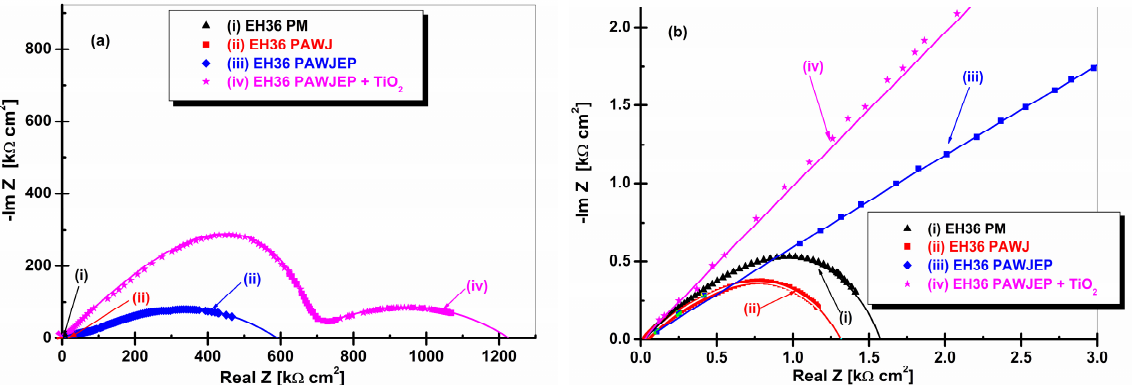
Figure 10. Electrochemical impedance spectroscopy diagrams in Nyquist representation for investigated samples in seawater on large frequency range ( a ) and zoom in low frequency range ( b ) for: (i) EH36PM without protective coating used like parent material, (ii) EH36PAWJ without protective coating, (iii) EH36PAWJEP coated with polymeric primer and (iv) EH36PAWJEP + TiO 2 coated with nanocomposite polymeric primer with dispersed TiO 2 nanoparticles. The plain symbols represent the experimental data, while the lines represent the fitting diagrams.